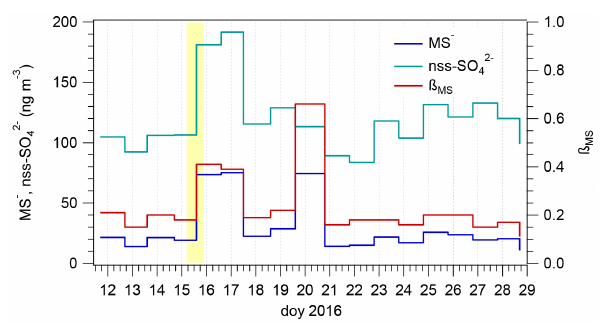
Figure 10. Time series of the measured MS − and nss–SO 2 − centrations as well as the MS − / nss–SO 2 − bulk aerosol (low volume) sampling during the campaign 2016. The period of LPS16 is shaded in yellow.